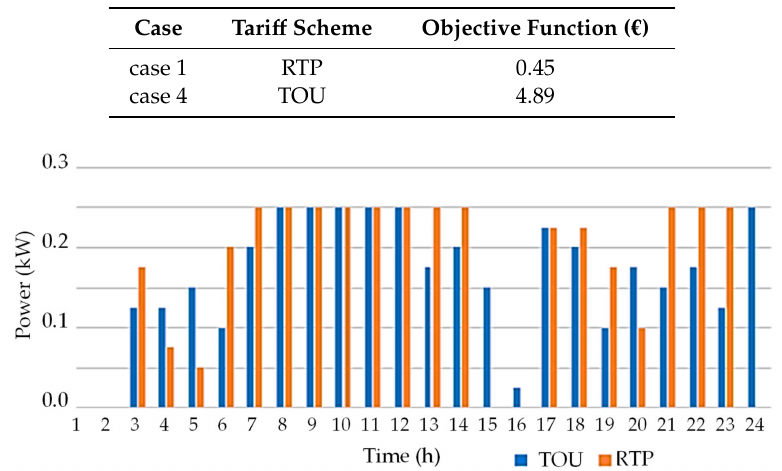
Table 2. Objective function results from the best di ff erent tari ff s schemes: Revenue in Euros (best case).